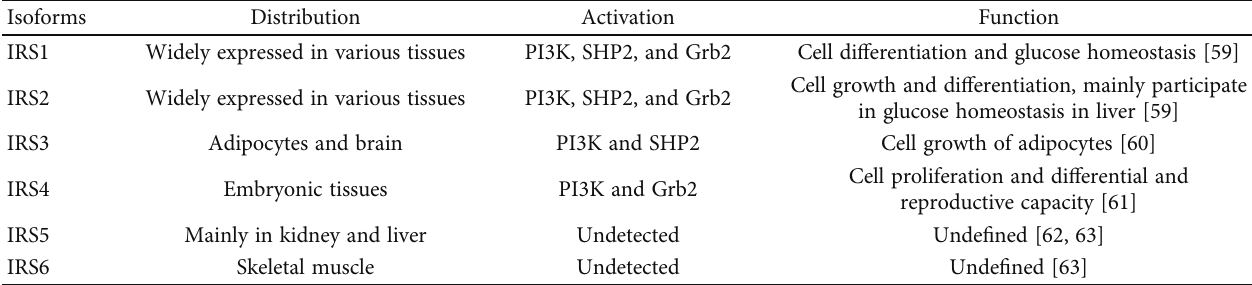
Table 2: Distribution and functions of di ff erent IRS